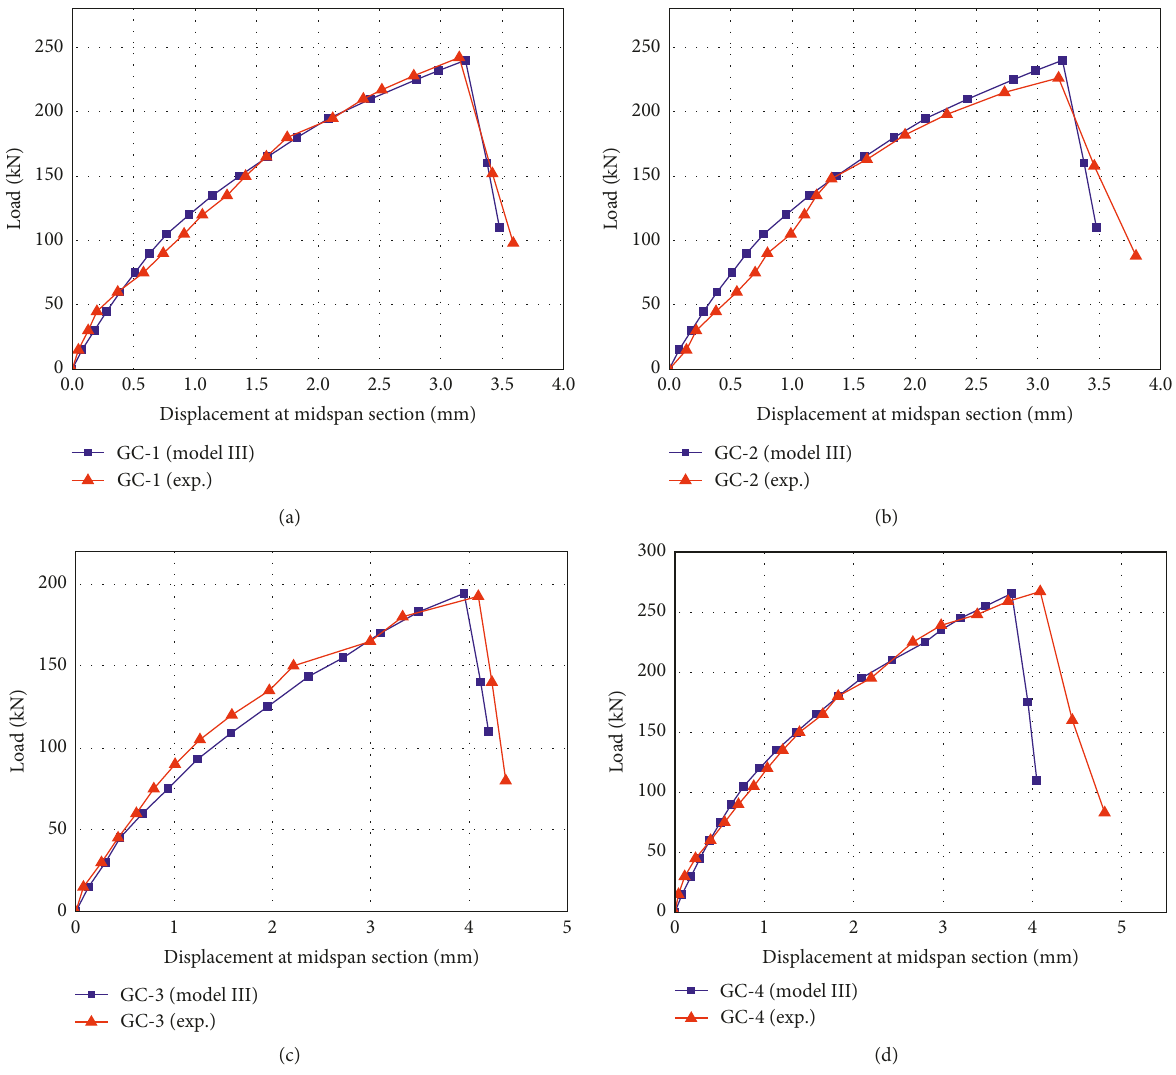
Figure 13: Comparison of the load-deflection curve at midspan cross section: (a) specimen GC-1; (b) specimen GC-2; (c) specimen GC-3; (d) specimen GC-4. Table 5: Comparison of experimental results and predicted results of the mixed elements method. Specimen